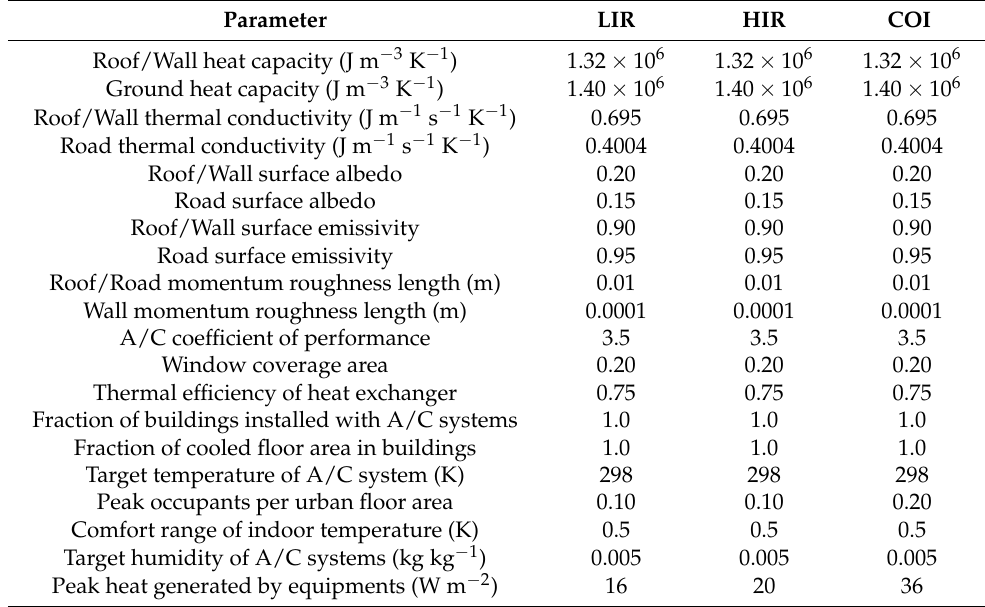
Table 1. Urban parameters for the YSU BEP+BEM simulations. The values of the parameter for the LIR, HIR, and COI urban classes are in columns 2–4.